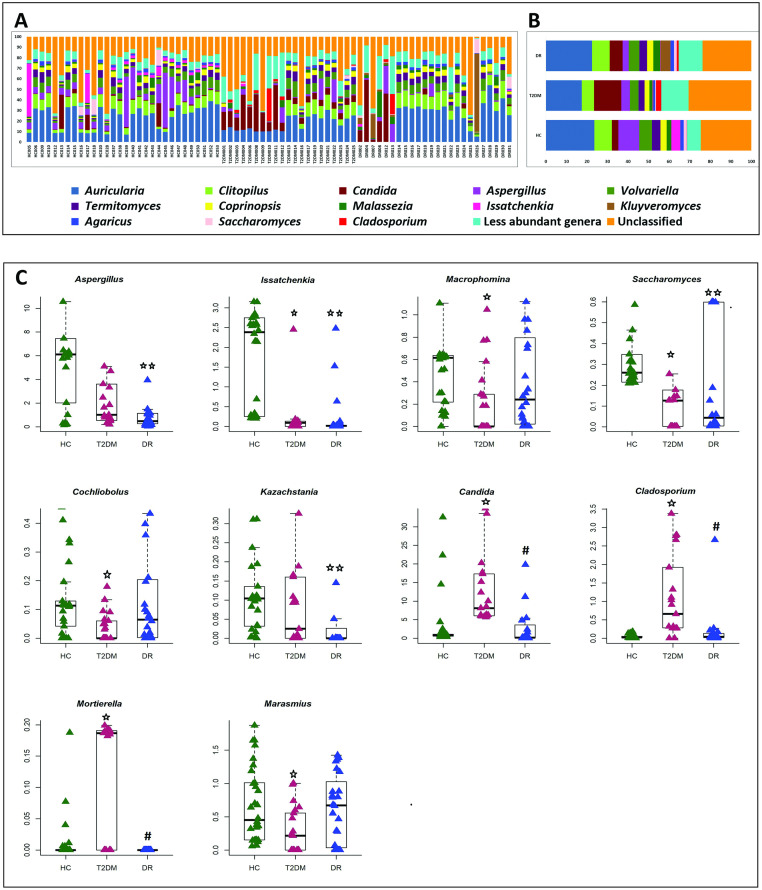
Diversity of different fungal genera in the gut mycobiomes of healthy controls (HC, n = 30), Type 2 Diabetes Mellitus (T2DM, n = 21) and Diabetic Retinopathy (DR, n = 24) patients.(A) Abundance and (B) mean abundance (%) of different fungal genera. Genera with < 1% mean abundance were categorized as ‘‘less abundant genera”. (C) Fungal genera exhibiting significant (Wilcoxon test, BH corrected p < 0.05) differential abundance in the gut mycobiomes HC, T2DM and DR patients. Median abundances (horizontal line) and inter-quartile ranges are indicated in the plots. Statistically significantly abundant genera between HC and T2DM are indicated by ★, between HC and DR are indicated by ★★ and between T2DM and DR are indicated by #.